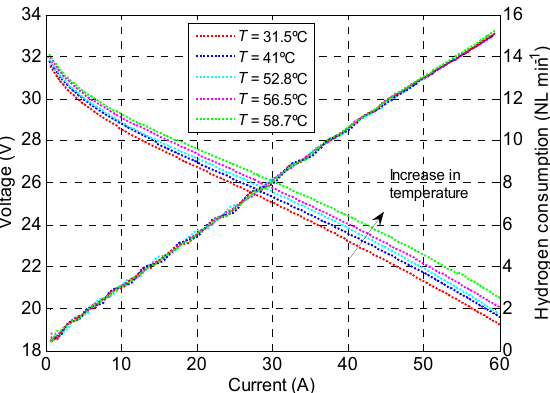
Figure 4. Experimental I-V characterisation curves and hydrogen consumption for a temperature range from 31.5 to 58.7